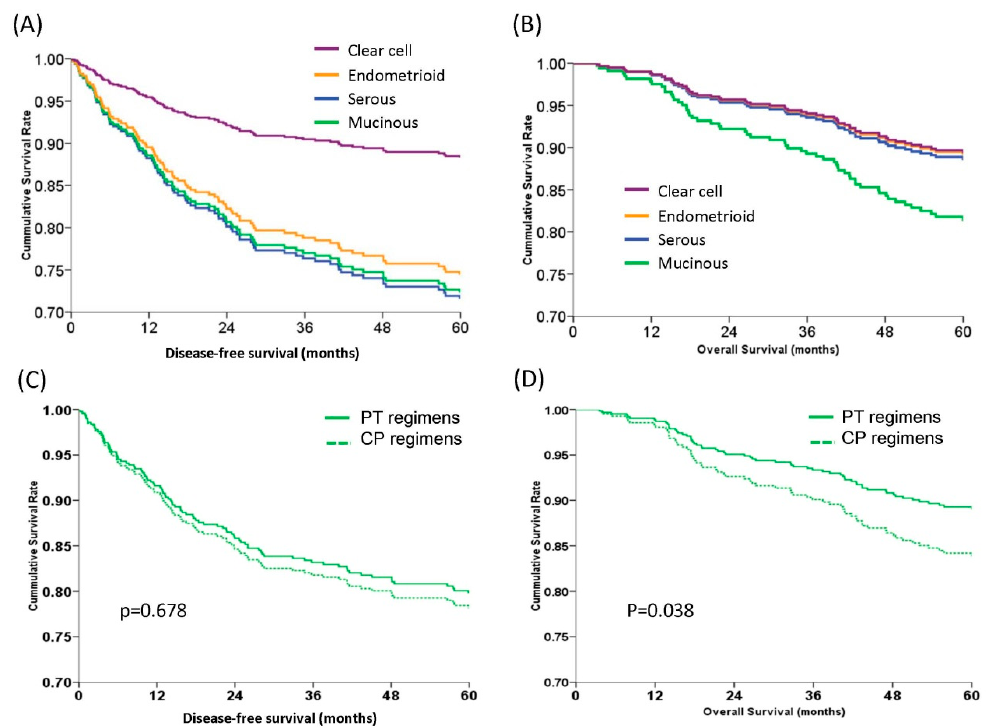
Figure 1. Survival curves of 437 early stage epithelial ovarian carcinoma women with different histologic types or chemotherapeutic regimens by multivariate Cox regression models. ( A ) Estimated 5-year disease-free survival (DFS) curves. The clear cell type (88.3%) demonstrated the best 5-year DFS vs. the endometrioid (74.4%, aHR = 0.45, 95% CI = 0.21–0.98, p = 0.038), mucinous (72.3%, aHR 0.35, 95% CI = 0.16–0.79, p = 0.014), and serous (71.5%, aHR = 0.37, 95% CI = 0.21–0.73, p = 0.001) types by log-rank test. The 5-year DFS rates of patients with endometrioid, mucinous, and serous type did not differ ( p = 0.177). ( B ) Estimated 5-year overall survival (OS) curves. The mucinous histology showed a trend towards a worse 5-year OS (81.1%) compared with the other histologic types, although it did not reach statistical significance (clear cell 89.2%, p = 0.143; endometrioid type 89.1%, p = 0.081; serous type 88.4%, p = 0.248). ( C ) Estimated 5-year disease-free survival (DFS) curves. There were no differences in the 5-year DFS rates between platinum and paclitaxel (PT) or platinum and cyclophosphamide (CP) regimens (79.8% vs. 78.2%, aHR = 0.92, 95% CI = 0.61–1.38, p = 0.678). ( D ) Estimated 5-year overall survival (OS) curves. Patients receiving the PT regimens had better 5-year OS than those receiving the CP regimens (89.3% vs. 82.7%, aHR = 0.59, 95% CI = 0.36–0.57, p = 0.038) (all by log-rank test).